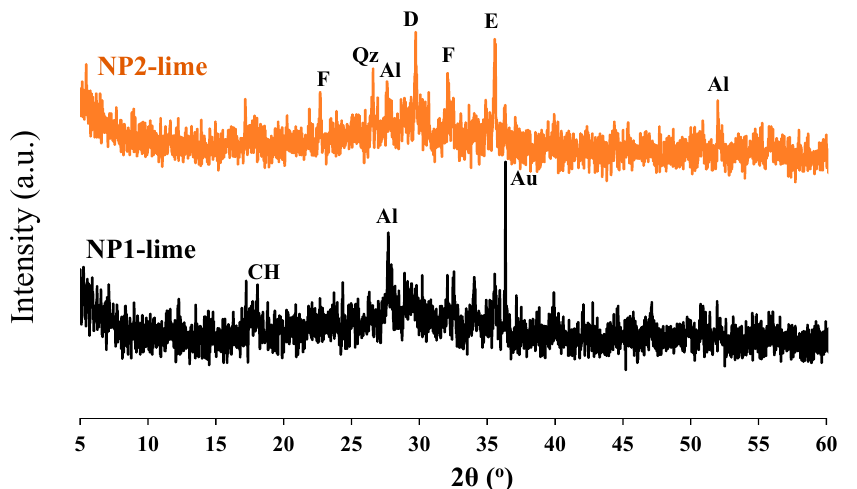
Figure 14. XRD analysis of tested NP–lime mixes. Al: albite, An: anorthite, Au: augite, E: enstatite, D: diopside, F: frosterite, M; mullite Qz: quartz; CH: portlandite.